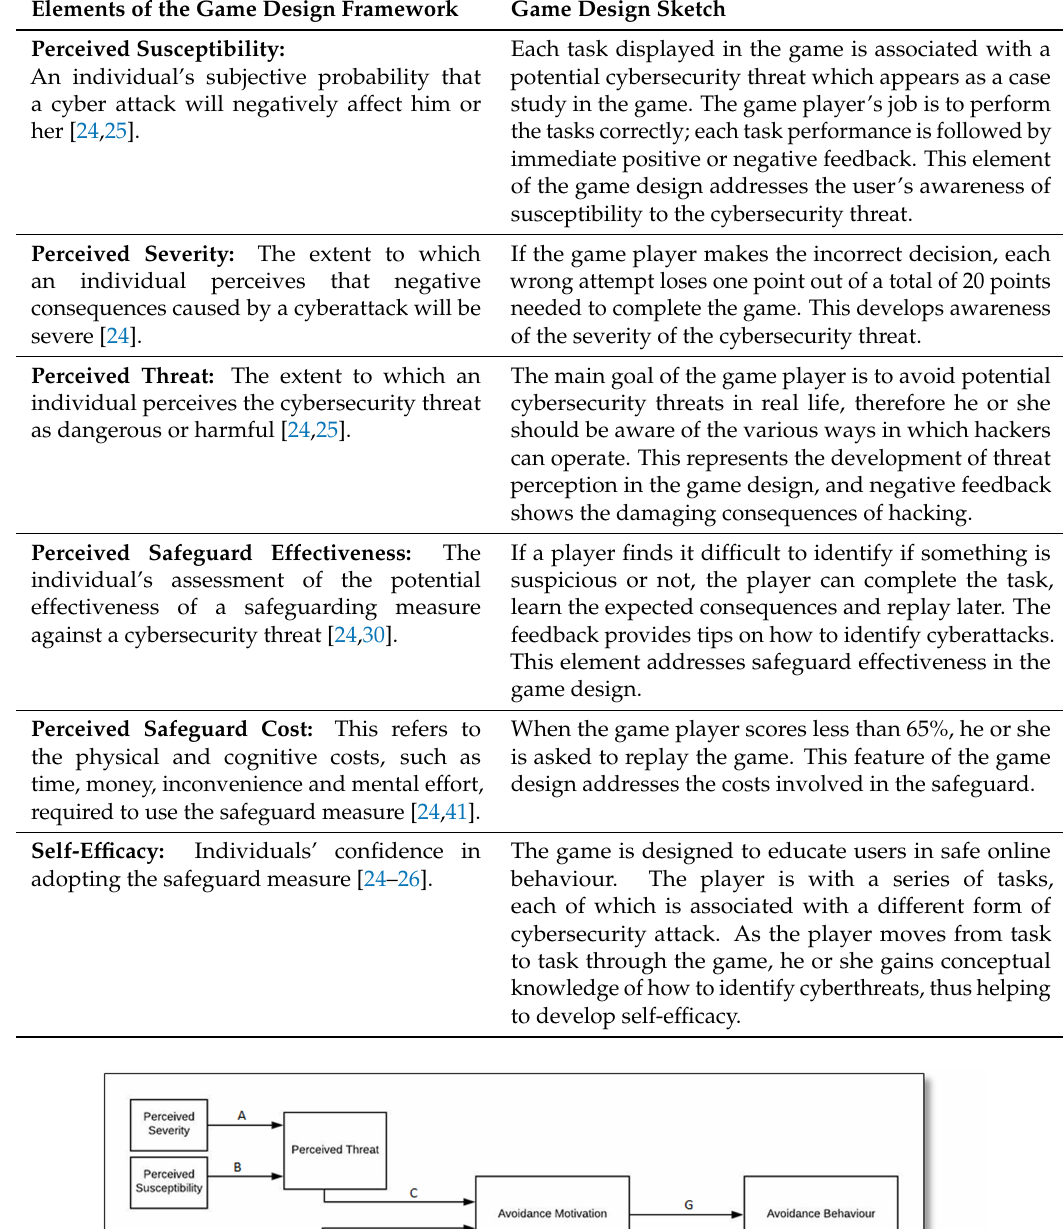
Table 1. Requirements for game design.